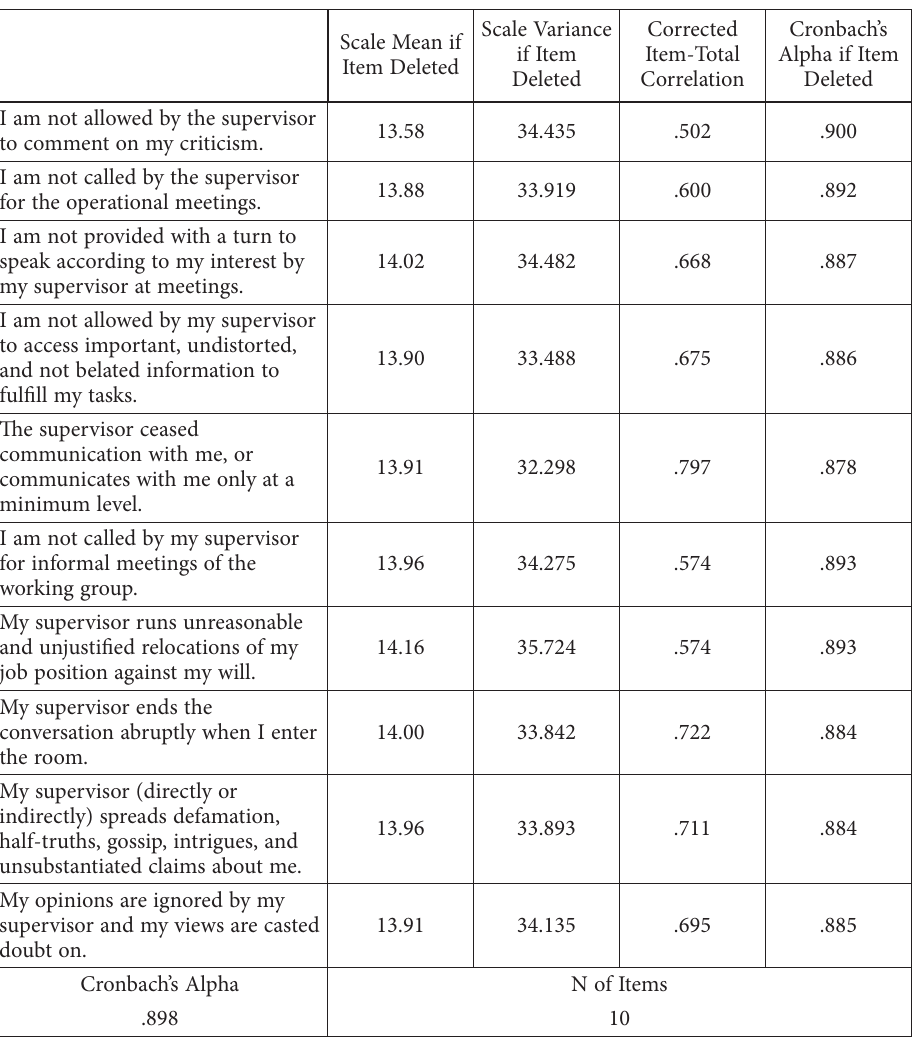
Table 2. Communication-Aimed Bossing internal